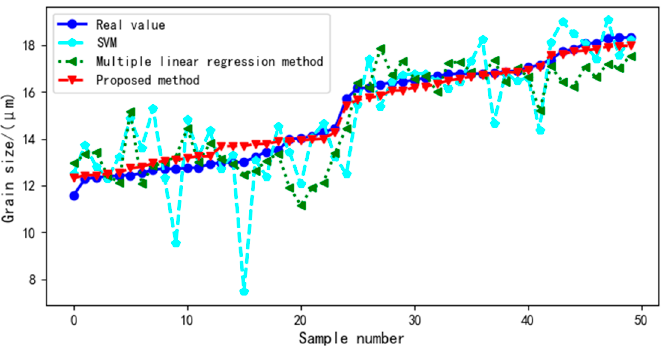
Figure 10. Contrast curve graph between the test sample value and the predicted value of the test sample in the multi-ultrasonic feature evaluation model.